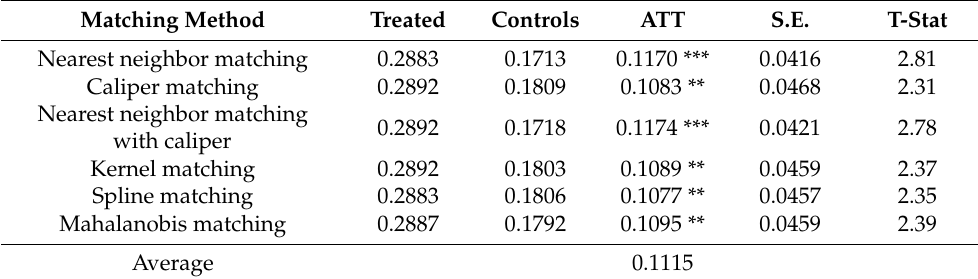
Table 4. The effect of formal credit participation on online purchases utilization. Matching